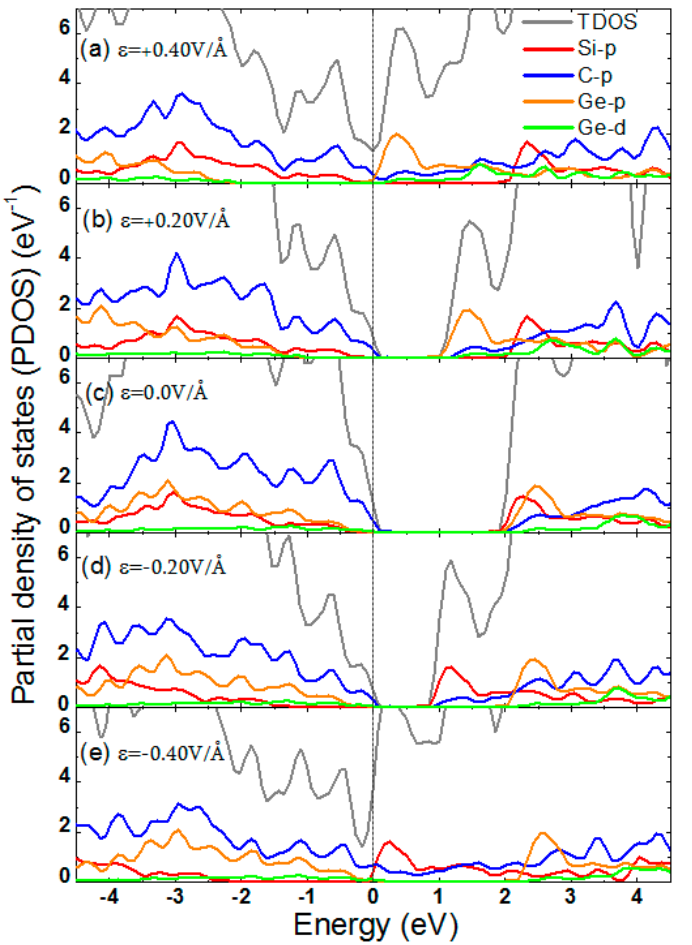
Figure 7. (Color online) Partial densities of states (PDOSs) of the SiC/GeC vdW heterostructures with different E-field strengths. The Fermi level is marked by the black dashed line.